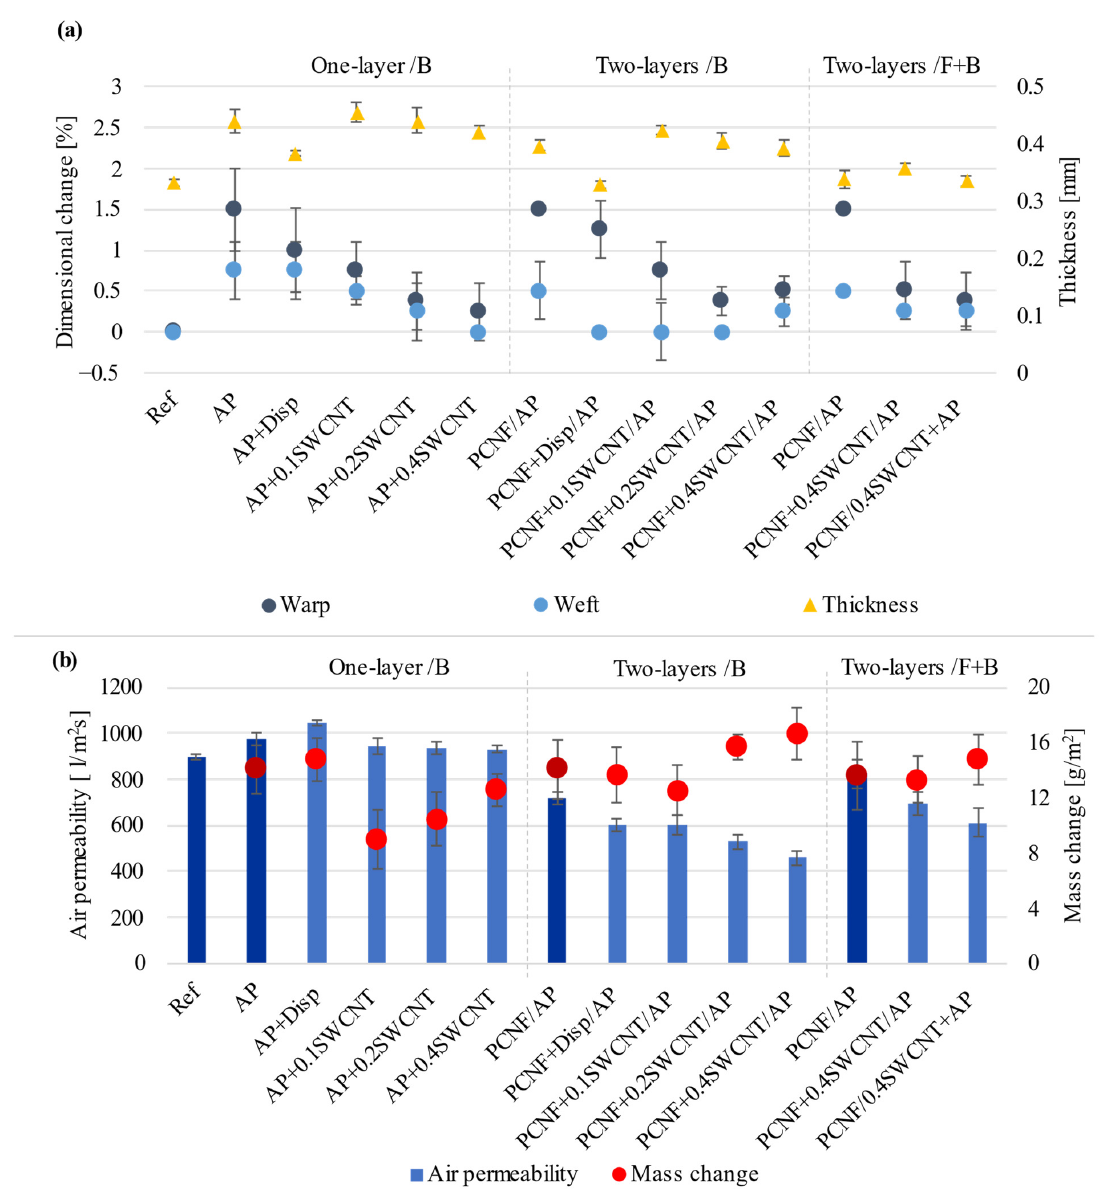
Figure 3. The effect of printing on the fabric’s: ( a ) Dimensional change and Thickness, and ( b ) Air permeability and coating’s Mass change values.